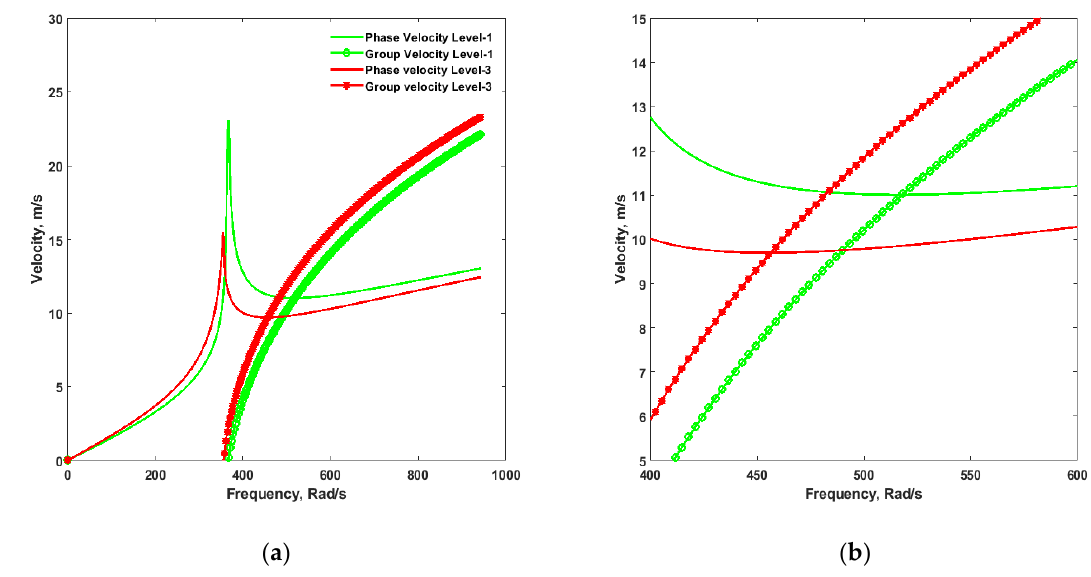
Figure 3. ( a ) Comparison of Dispersion Curves for Level-1 and Level-3, ( b ) Close View of ( a ).